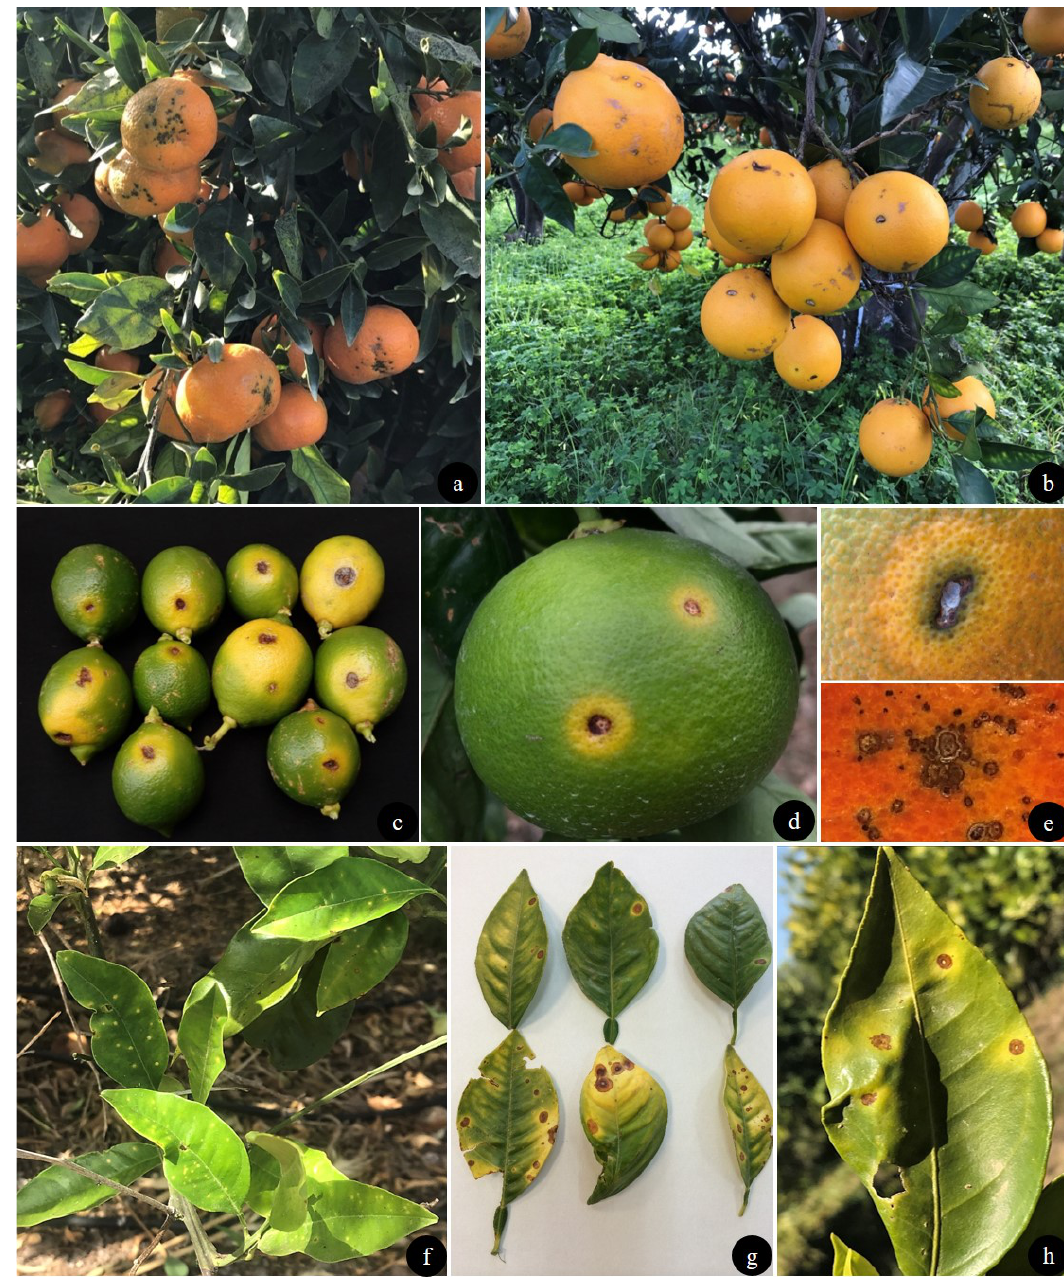
Figure 2. Alternaria brown spot: ( a ) brown spot on “Mandalate” mandarin; ( b ) brown spot on “Tarocco Scirè VCR”; ( c ) depressed brown to black lesions surrounded by yellow halo areas and gummosis on immature “Femminello Siracusano 2KR” lemon fruit; ( d ) brown spot lesions with yellow halo areas on “Tarocco Gallo VCR” immature fruit; ( e ) detail of fruit spots (specks to craters symptoms) on “Tarocco Sciara” (up) and “Nova” mandarin (down); ( f ) chlorotic leaf spots on young leaf of “Tarocco Emanuele”; ( g , h ) necrotic spots with yellow halo of expanded leaves of Tarocco blood oranges.